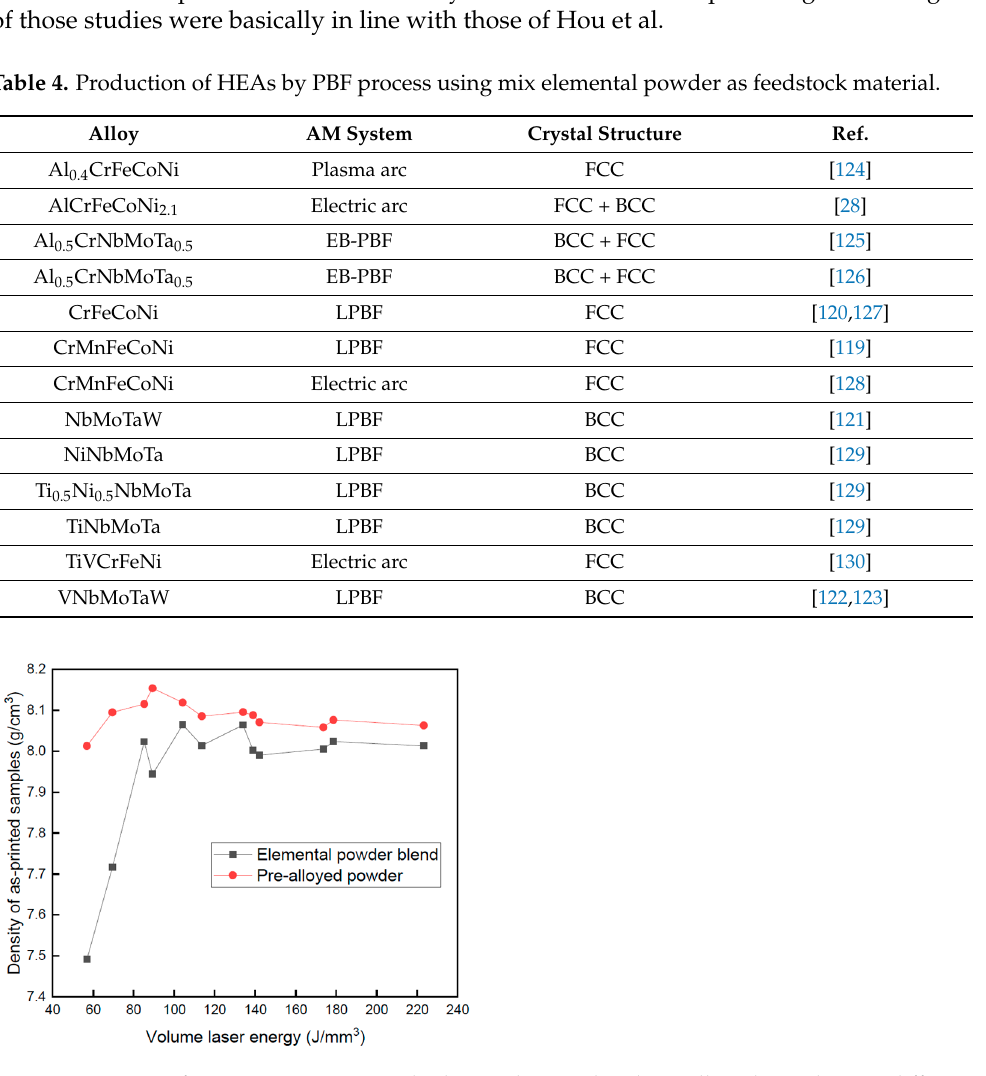
Figure 9. Macroscopic structure by optical microscopy of HEA VNbMoTaW obtained by various LPBF trials using mix elemental powder: ( a ) LPBF—Primary trials, ( b ) LPBF—Intermediate trials, ( c ) LPBF—Advanced trials. 2.3. Direct Energy Deposition (DED) DED is an AM process in which a high energy source, such as a laser beam or plasma arc, is used to melt and deposit material onto a substrate [131]. The feedstock material, which can be either mix elemental powder or pre-alloyed powder, is melted and fused to the previous layer to create metallurgical bonds between layers. The DED process has a higher deposition rate than PBF technologies and is mostly not limited by the size of the printing chamber. However, the surface roughness of DED-produced parts is generally lower and the complexity of parts that can be produced is limited compared to PBF sys- tems [132]. The main processing parameters of the DED process are energy/power, scan